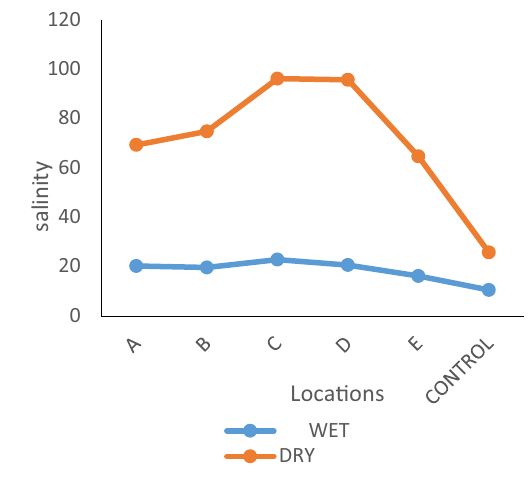
Fig. 5 The chart showing the variation in salinity